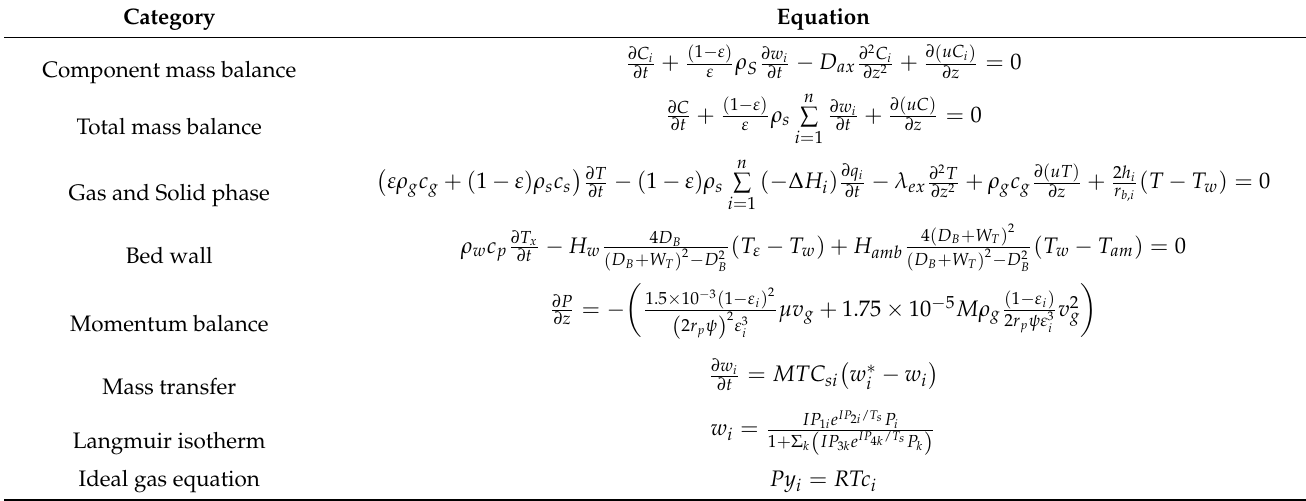
Table 2. Mathematical model of 1D non-isothermal adsorption bed.